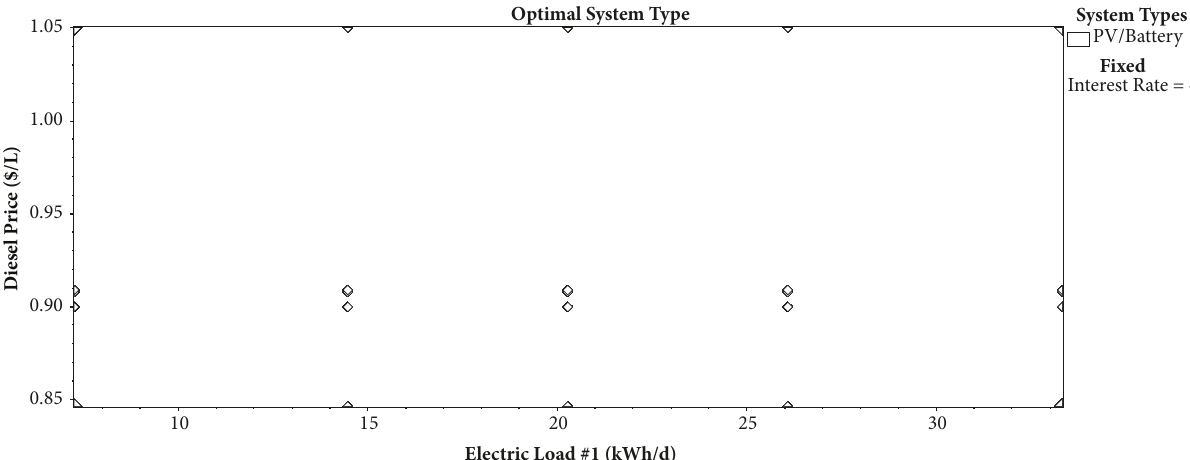
Figure 12: Sensitivity analysis at 8% nominal discount rate.